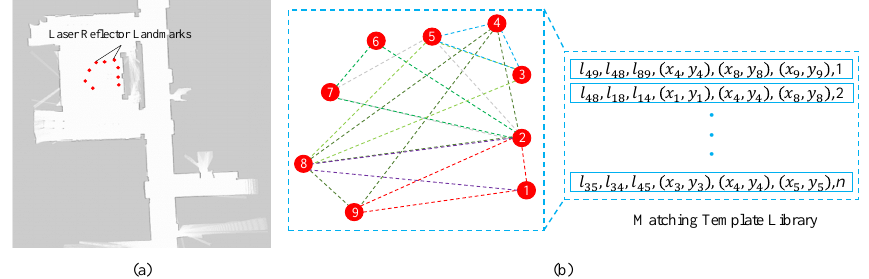
Figure 1. Map building and template library establishment. ( a ) Map generated by Gmapping [46], where the red dots are laser-reflector landmarks. ( b ) Establishing the matching template library M of the laser-reflector landmarks. In the template library, all items contain the side length and the vertex coordinates of the triangles and are sorted by the maximum side